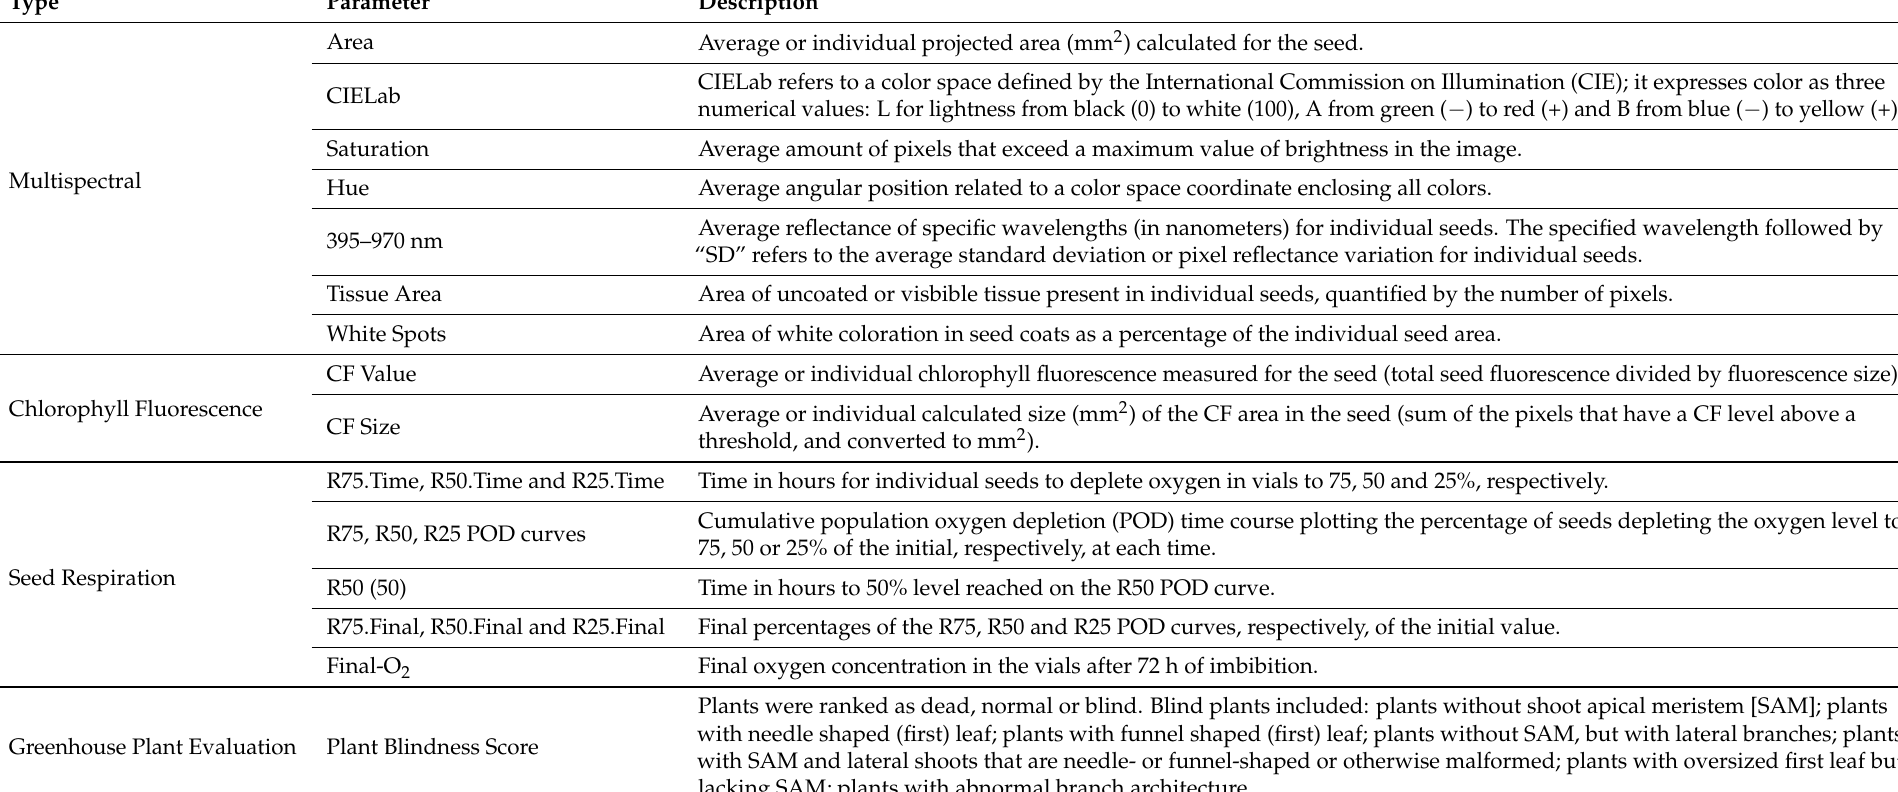
Table 1. Parameter